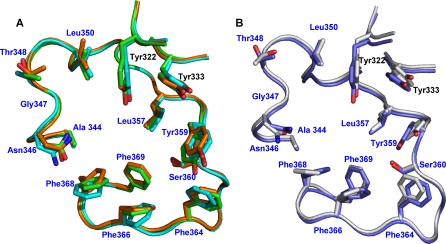
Superposition of Mtd-P1 Variable Regions(A) Mtd-P1 sites from the Mtd-P1·Prn-E complex that bind the major (orange) or minor (green) pertactin loops or no pertactin loop (cyan) are superposed (average root-mean-square deviation 0.303 Å for 376 Cα atoms). The backbone is shown in curvilinear representation, and side chains of variable residues, along with the invariant residues Tyr322 and Tyr333, are shown in stick representation. Variable residues are labeled in blue, and invariant ones in black.(B) The Mtd-P1 site from the Mtd-P1·Prn-E complex that binds the major pertactin loop (gray) is superimposed with a site from unbound Mtd-P1 (blue) (root-mean-square deviation 0.450 Å for 376 Cα atoms).